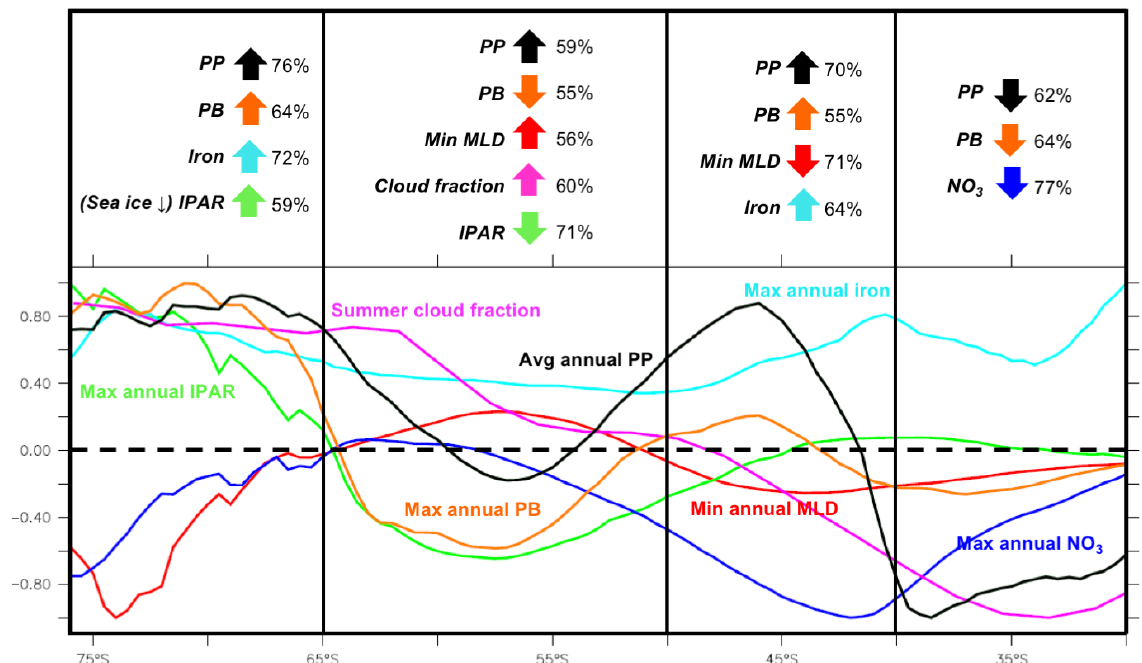
Figure 6. Summary of predicted phytoplankton responses and their drivers within each zonal band. Here each coloured line represents normalized 100-year all-model mean zonal changes in the listed variable. Each variable was normalized by first computing the all-model mean zonally averaged 100-year change at every latitude and then dividing by the absolute value of the largest of these changes occurring south of 30 ◦ S. Listed above each band is the spatially averaged percentage of model realizations that agree on the sign of the change (based on a bootstrap analysis – see Sect. 2.2 and Fig. 5) in each variable over that band. The coloured arrows denote the direction of the trend agreed upon by the majority of models. The number of models ( n ) and the total model weight ( w ) taken into account for each variable are listed in Fig.